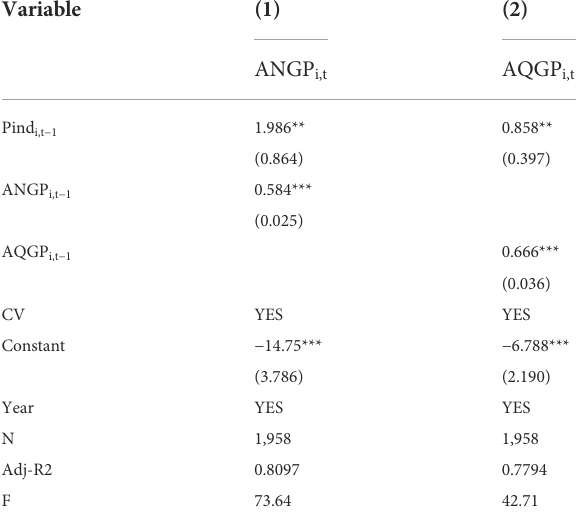
TABLE 3 Test results for the impact of the environmental administrative penalty on the peer enterprises ’ GTI.